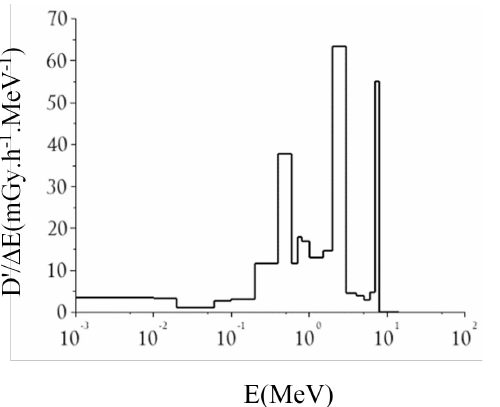
Figure 3. Photon–dose rate in water (in mGy · h − 1 MeV − 1 /MW) in the cellular irradiation box, normalized to 1 MW reactor power.